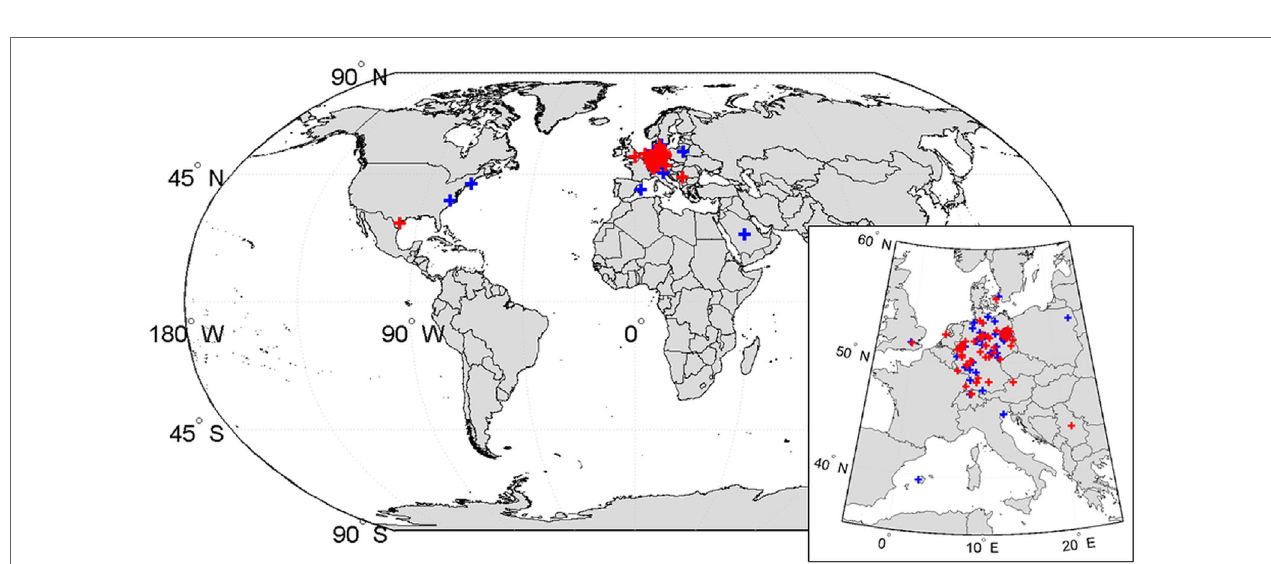
FigUre 2 | Geographical distribution of non-residents’ principal residences. The geographical locations of principal residences of non-resident patients with suspected stroke are displayed. Red crosses represent patients with a diagnosis stroke (73 patients), blue crosses stroke mimic (58 patients). The principal residence of most patients (114 of 131) was in Germany. Four patients had their principal residence outside of Europe: three patients were residents of the United States, one patient was a resident of Saudi Arabia. World borders dataset used to create the map from http://thematicmapping.org, available under a Creative Commons Attribution-Share Alike License